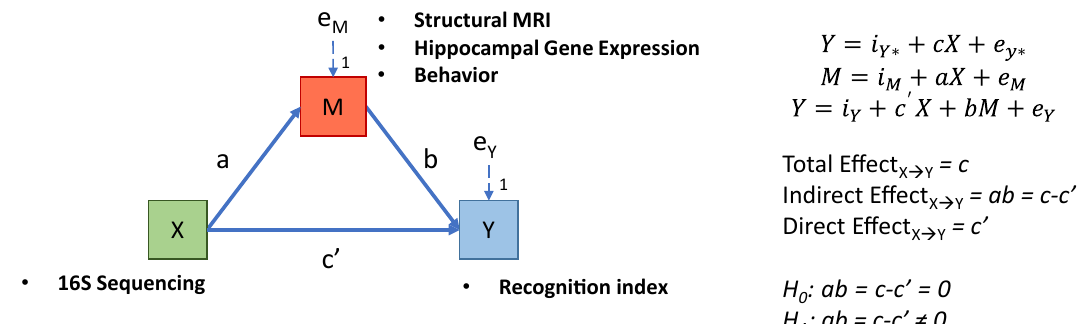
Figure 1. Schematic depicting the mediation models and regression paths. The objective of the mediation analysis was to determine if the indirect effect (paths a*b, which is equal to paths c-c’) was different from zero, suggesting the mediating variable altered the strength of the relationship between X and Y. Three models were used to assess the mediation: X regressed on Y, X regressed on M, and both X and M regressed on Y. The letters a, b, c, and c’ refer to estimates the beta coefficients for each respective model, with e representing the error